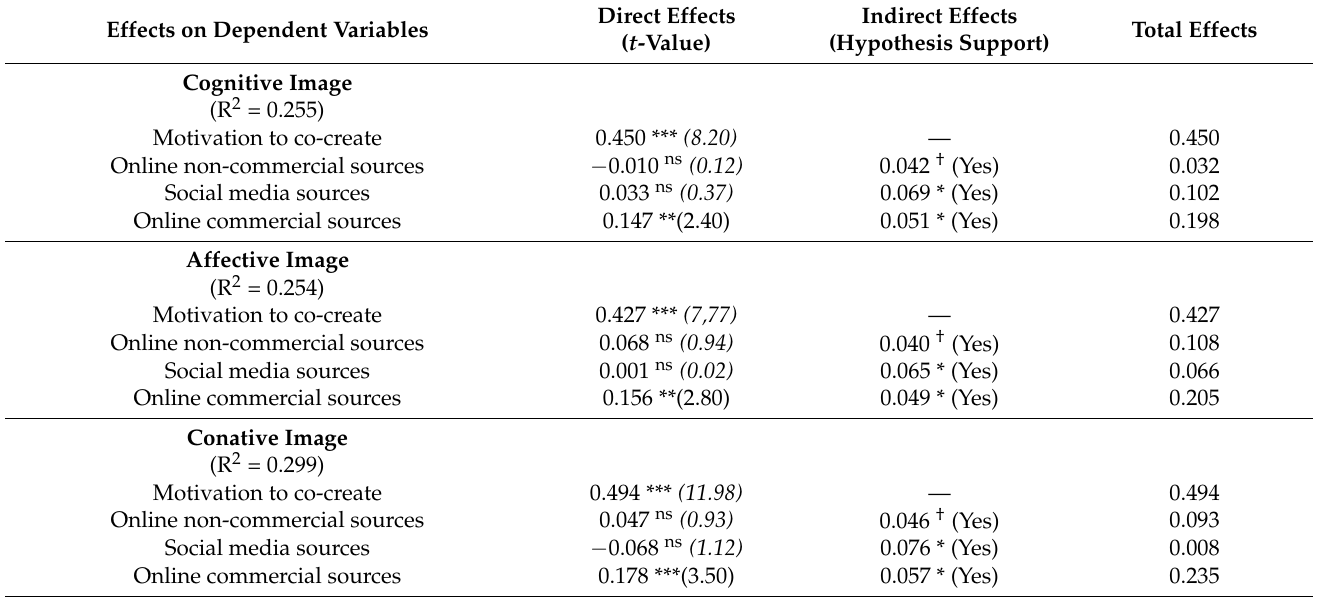
Table 7. Mediation hypothesis validation (H5–H7): direct, indirect, total effects and explained variance. Effects on Dependent